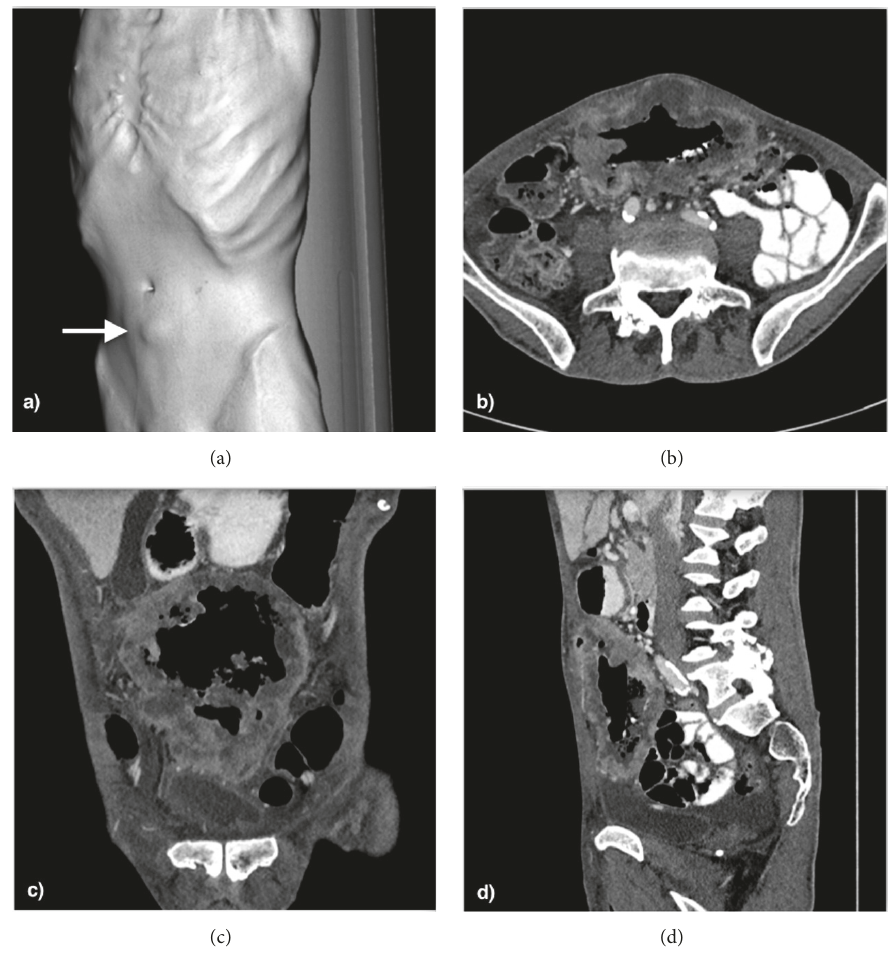
Figure 2: (a) 3D CT reconstruction showing an emaciated patient with a visible infraumbilical mass (arrow). Axial (b), coronal (c), and sagittal (d) contrast-enhanced CT images depicting a large and heterogeneous median abdominal mass, extending from the anterosuperior aspect of the bladder toward the